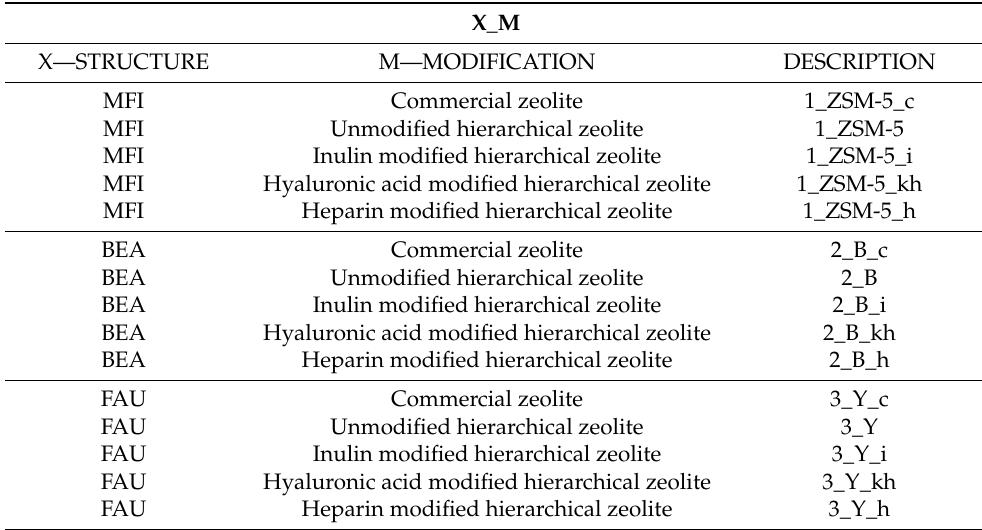
Table 1. Designation of materials used in the